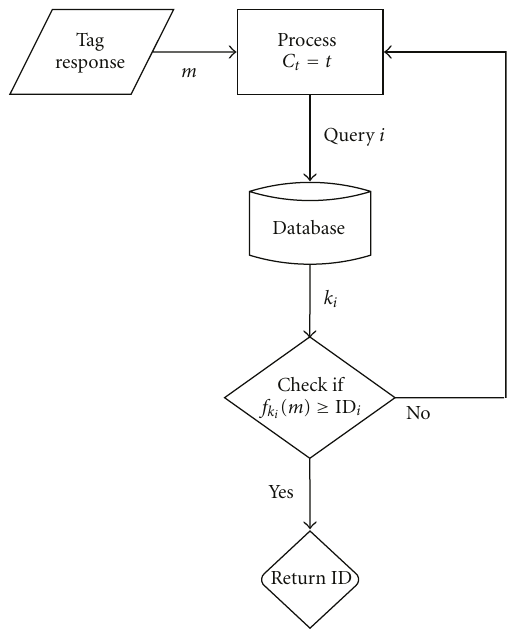
Figure 1: Standard exhaustive search having the general term C t = t